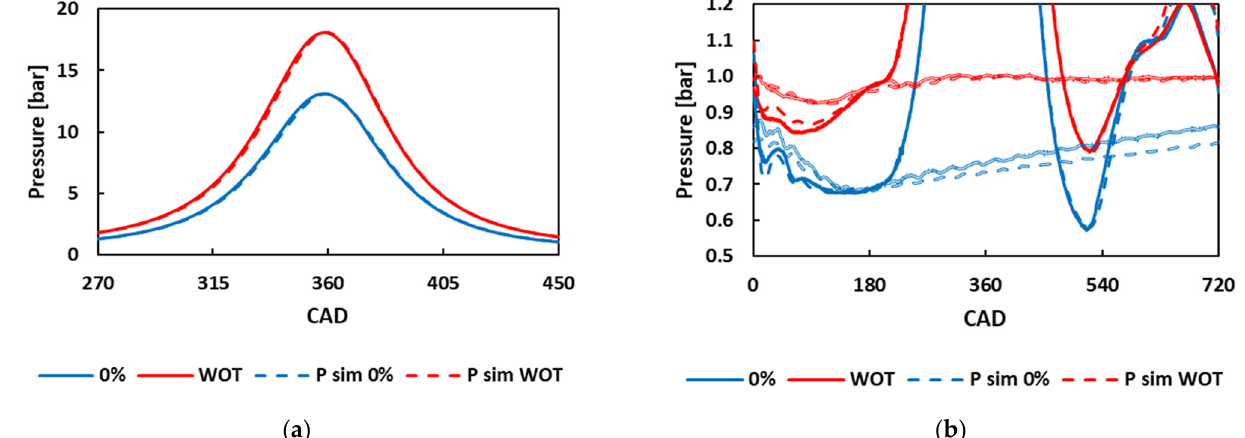
Figure 5. Simulated (dashed lines) and measured (solid lines) in-cylinder pressure traces at 2000 rpm, WOT, and completely closed throttle ( a ); the low pressure range also shows intake pressure traces ( b ).